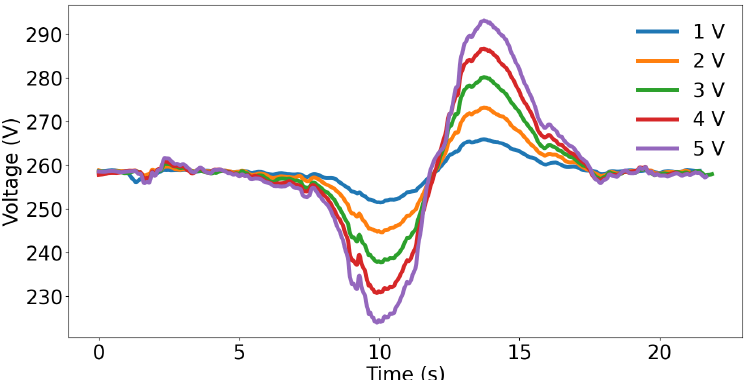
Figure 11. System voltage disturbances produced by different amplitudes of the feedforward signal for Cloud